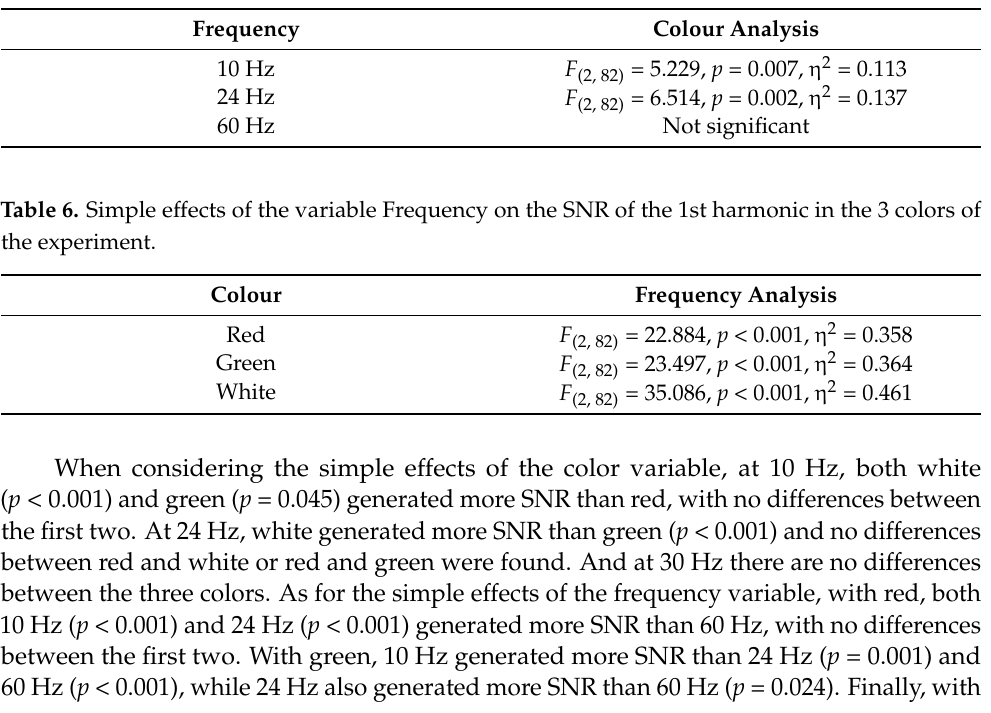
Table 5. Simple effects of color on SNR for the 1st harmonic for the 3 frequencies.